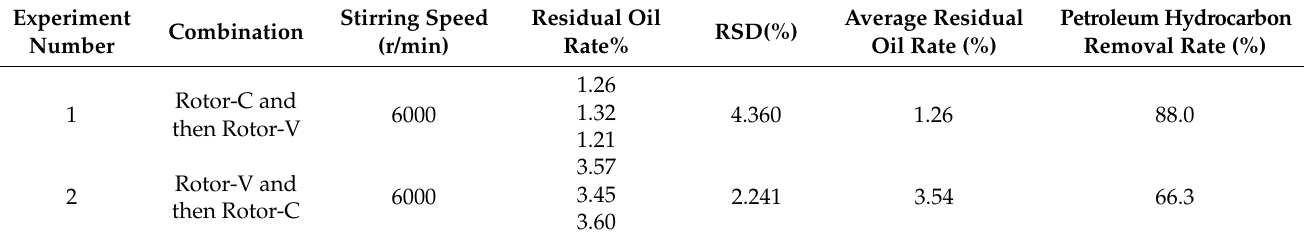
Table 1. Test results of the residual oil rate of the two-stage oily sludge